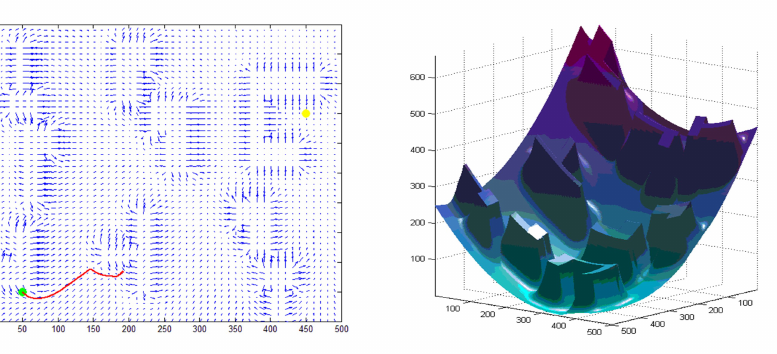
Figure 9. Experimental results of the artificial potential field method under similar scenes and the same starting point and end point settings